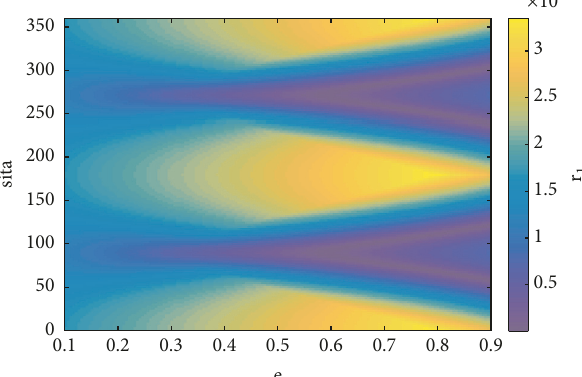
Figure 13: Closest distances corresponding to different initial phase and eccentricity values for 2:1 resonant